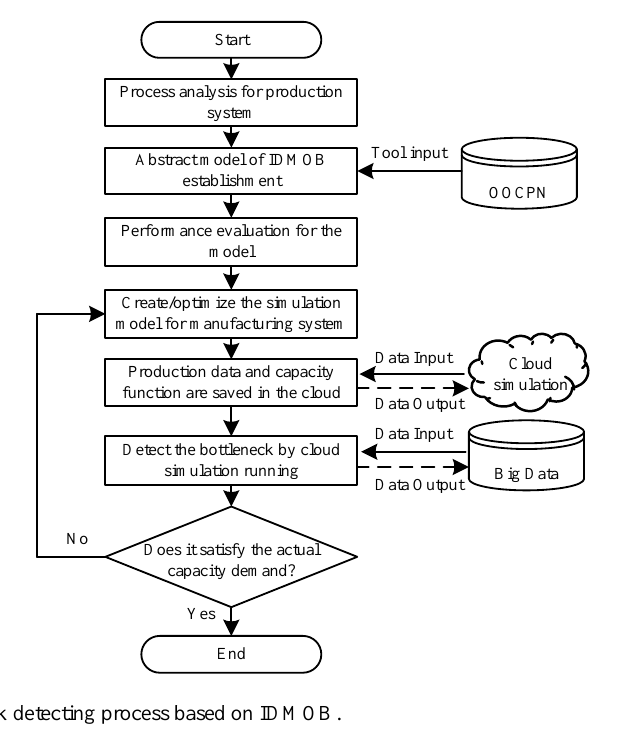
Fig. 1. Bottleneck detecting process based on IDMOB.